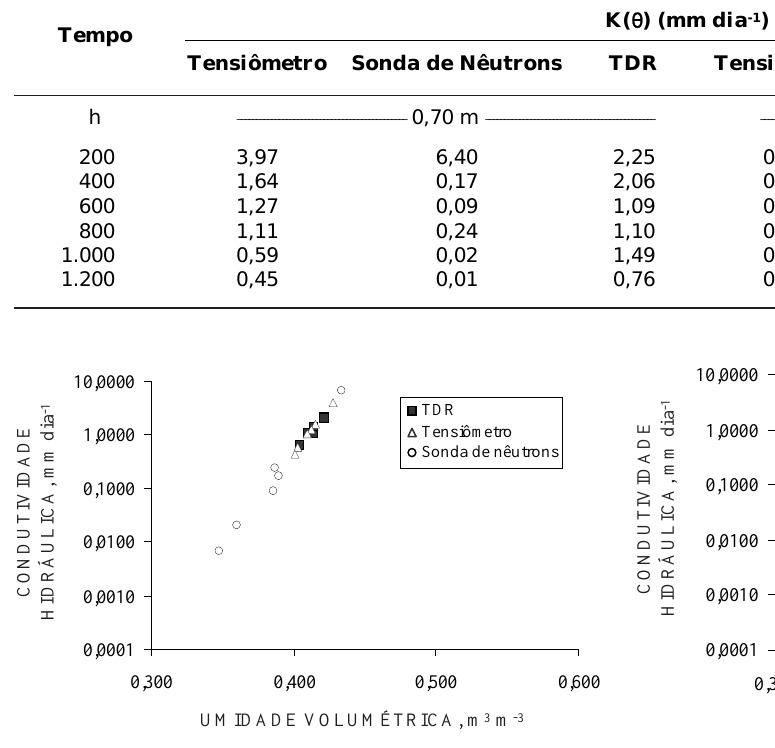
Figura 3. Condutividade hidráulica não saturada, considerando os três equipamentos, para a profundidade de 0,70